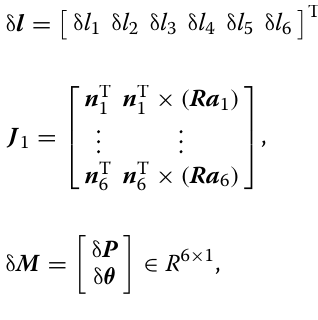
Figure 17 Relation between radius R ( R 0 ) and output pose errors: a δ